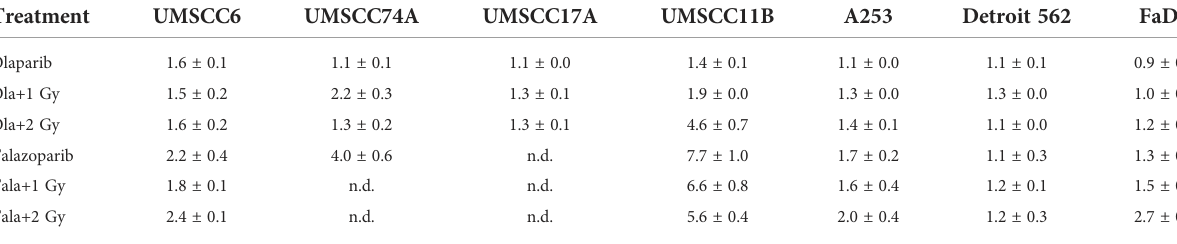
TABLE 2 Olaparib and talazoparib selectively enhance the sensitivity of HPV-negative HNSCC spheroids in response to x-ray irradiation. Treatment